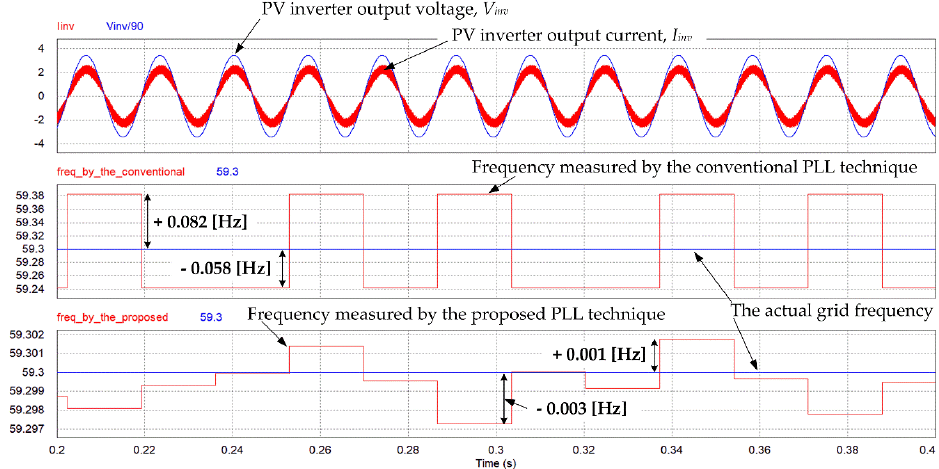
Figure 10. Key waveforms of the PV inverter when the grid voltage frequency is 59.3 Hz.